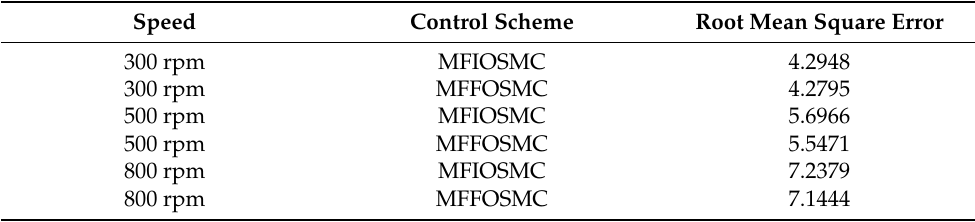
Table 2. Detailed comparison of the two control algorithms at different